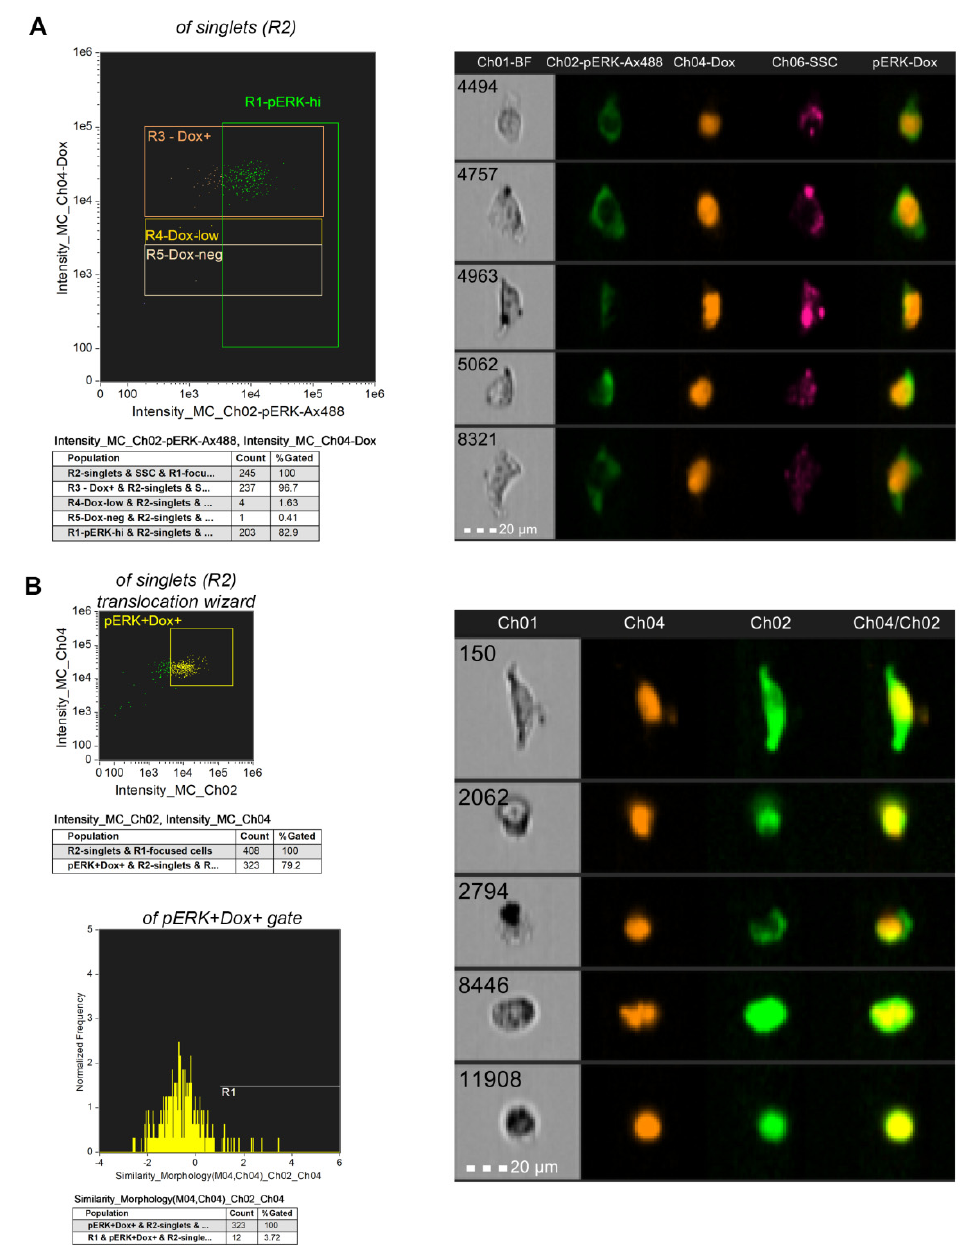
Figure 14. Imaging flow cytometry analysis of pERK expression at 3 h after incubation of A375 cells with 4 µg/mL Fe 3 O 4 -L-Cys-Dox nanoparticles. Phosphorylated ERK was detected on channel 02, and Dox on channel 04. Merged Ch02/Ch04 fluorescence, single-channel brightfield (Ch01) and side scatter (SSC, Ch06) images are provided. Dot plots as well as representative images of single cells are shown for each analysis. ( A ) R1 gate marks cells with high ERK activation, irrespective of Dox uptake level. Events from this gate are exemplified in the corresponding images. ( B ) Gated cells represent pERK + cells that have taken up the drug. Cells expressing pERK in the nucleus were analyzed using the translocation wizard (defined as R1). R1 events are exemplified in the last two rows of images in each data set.